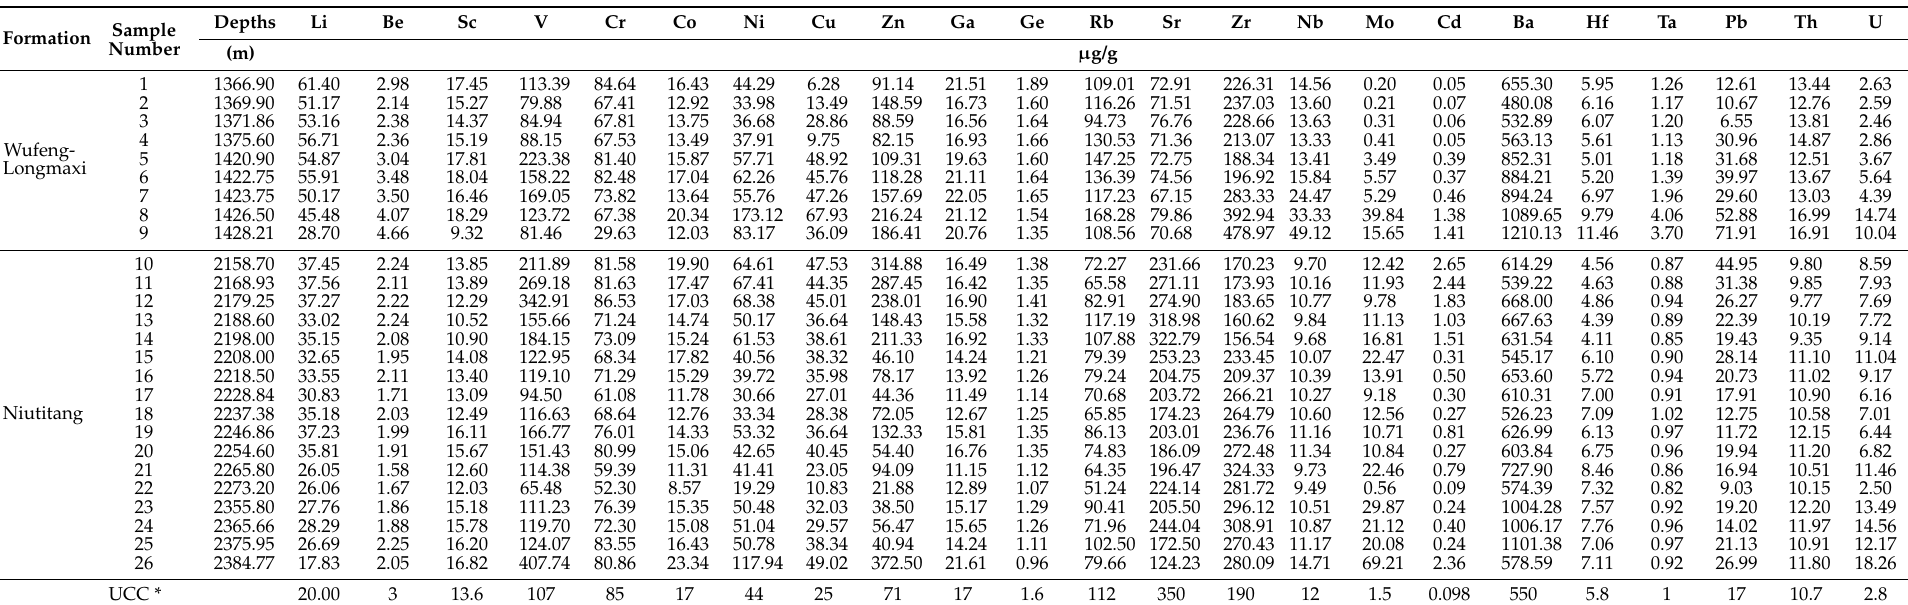
Table 3. Trace elements data of Wufeng-Longmaxi and Niutitang